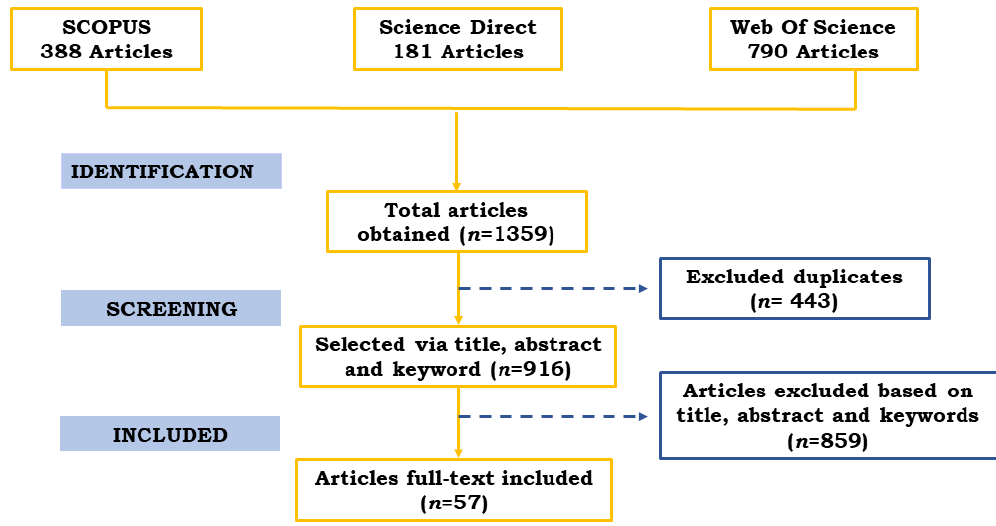
Figure 3. PRISMA flow diagram displaying systematic search results, indicating the total number of articles obtained from the databases ( n = 1359) and those selected according to the inclusion criteria ( n = 57). Table 2. Description of biosensors focusing on the type of nanomaterial